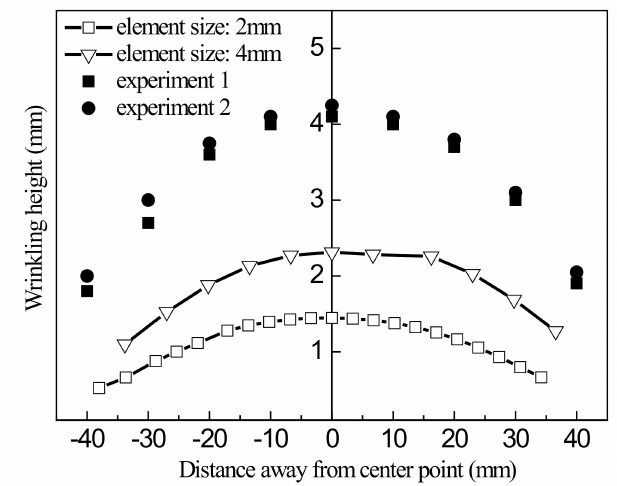
Figure 20. Comparison of simulation results using the S4R linear element and the static algorithm with experimental data.